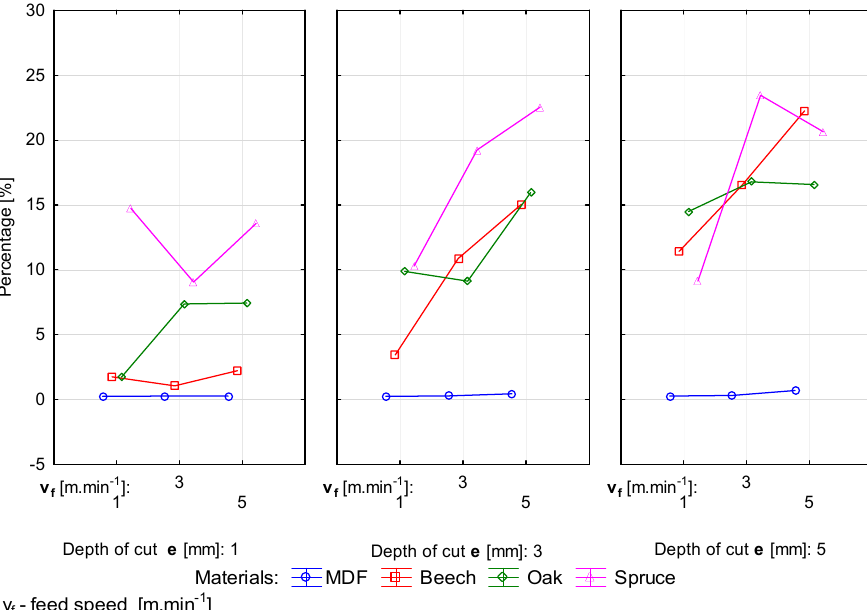
Figure 5. Grain size grade 250 μ m. Fine fractions, presented in Figures 6–9, are of the greatest importance from the point of view of assessing the occupational health risks to workers. Their distribution in ma- chining natural wood was as follows: 0.95% ÷ 16.07% (beech), 5.34% ÷ 15.03% (oak), and 5.47% ÷ 12.67% (spruce), respectively. Noticeably, no particles from the dust fractions be- low 32 μ m were determined. However, the finest dust particles that could be respirable when dispersed in the air are included in the larger sieve fractions. Due to their shape, they cannot pass through sieves with small apertures and join to the larger particles. The weight ratio of particles below 125 μ m was represented by the following shares: 0.45% ÷ 4.06% (beech), oak wood 0.92% ÷ 5.86% (oak), and 1.72% ÷ 5.5% (spruce), respectively. The